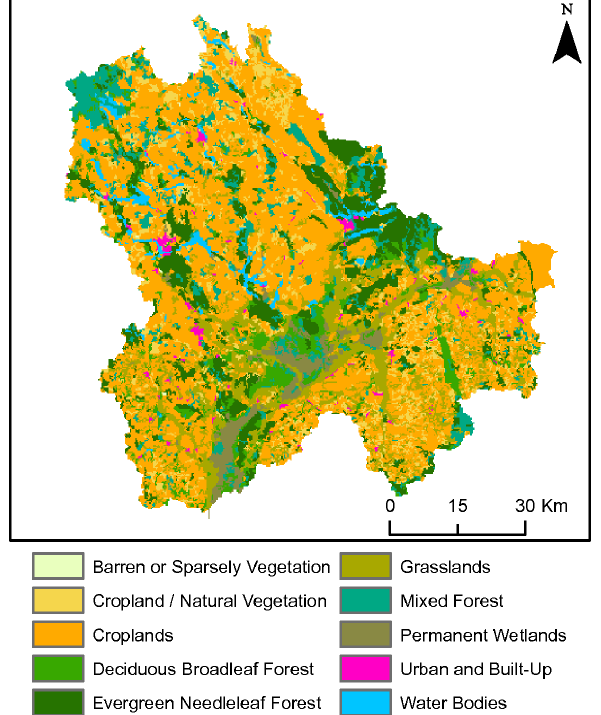
Figure 3. Land use in the study area. Land-use classes are the same as used in the WetSpa model, defined by International Geosphere– Biosphere Programme classification system.